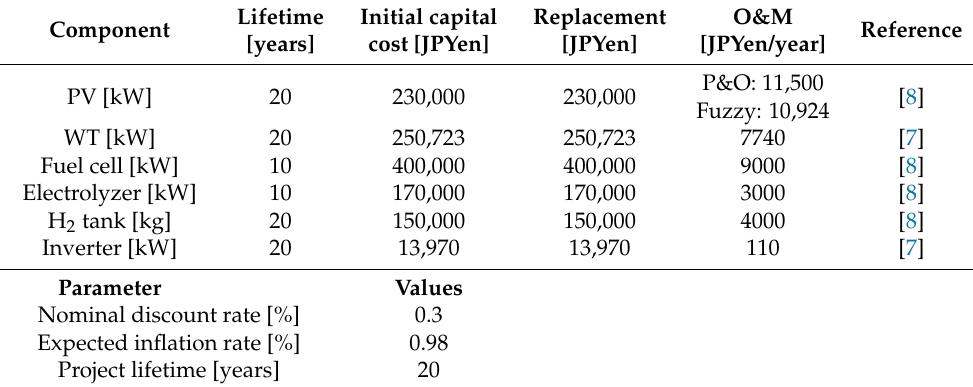
Table 9. Costs items of the main components of the proposed HRES.